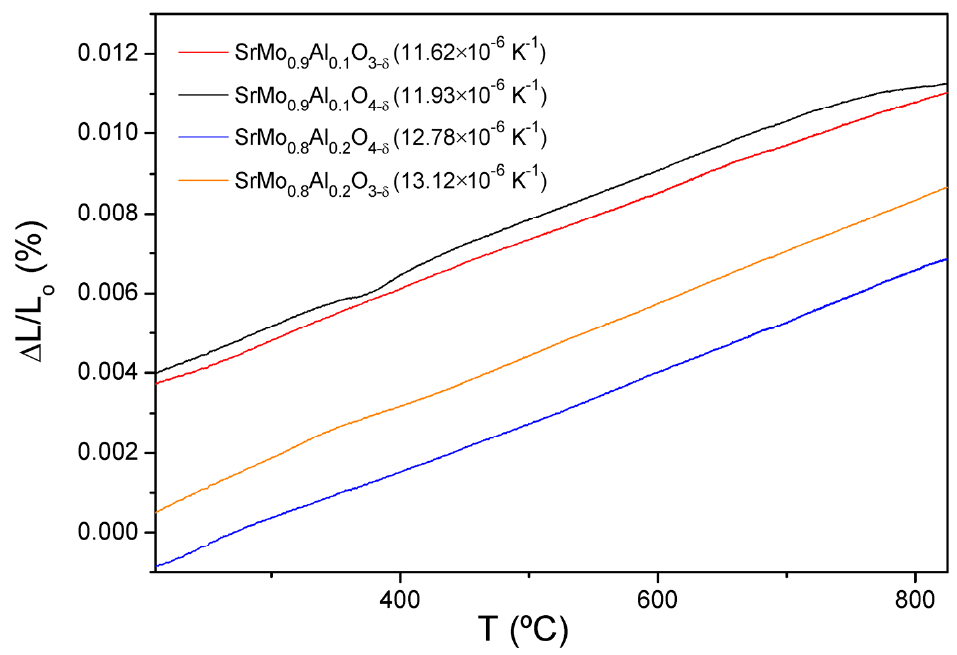
Figure 5. Thermal expansion determined by dilatometry of the SrMo 1 − x Al x O 3 − δ and SrMo 1 − x Al x O 4 − δ series.